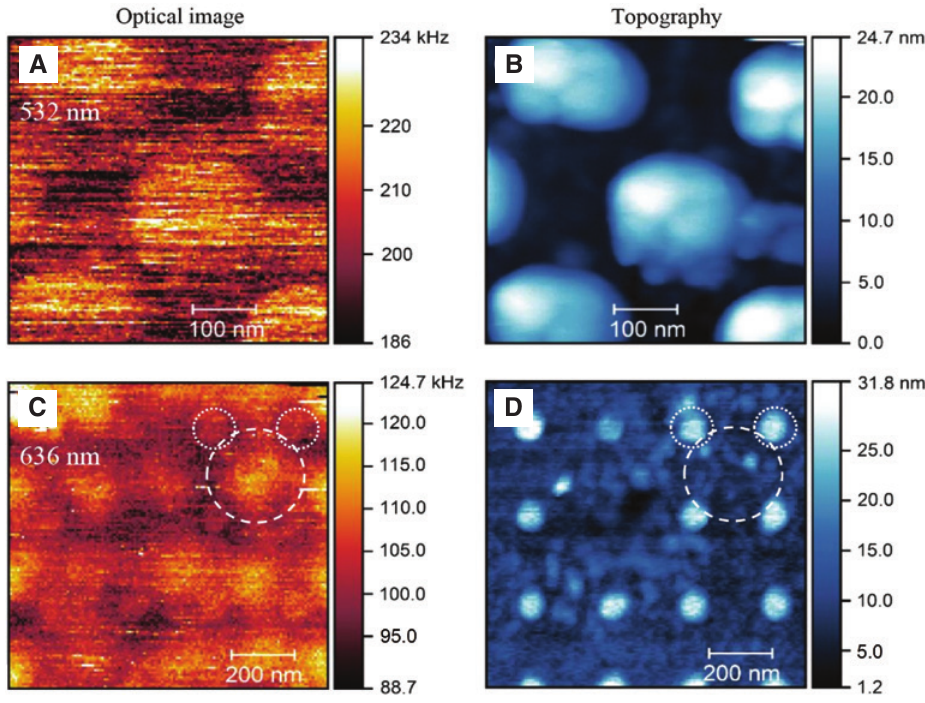
Figure 5: TERS images of CoPc at different excitation wavelengths. TERS images recorded with (A) 532 nm excitation and (C) 636 nm excitation. (B) and (D) are the simultaneously recorded topographic images, respectively. Excitation power at the sample is ~ 200 μ W for both 532 and 636 nm excitations. The incident polarizations for both 532 and 636 nm are